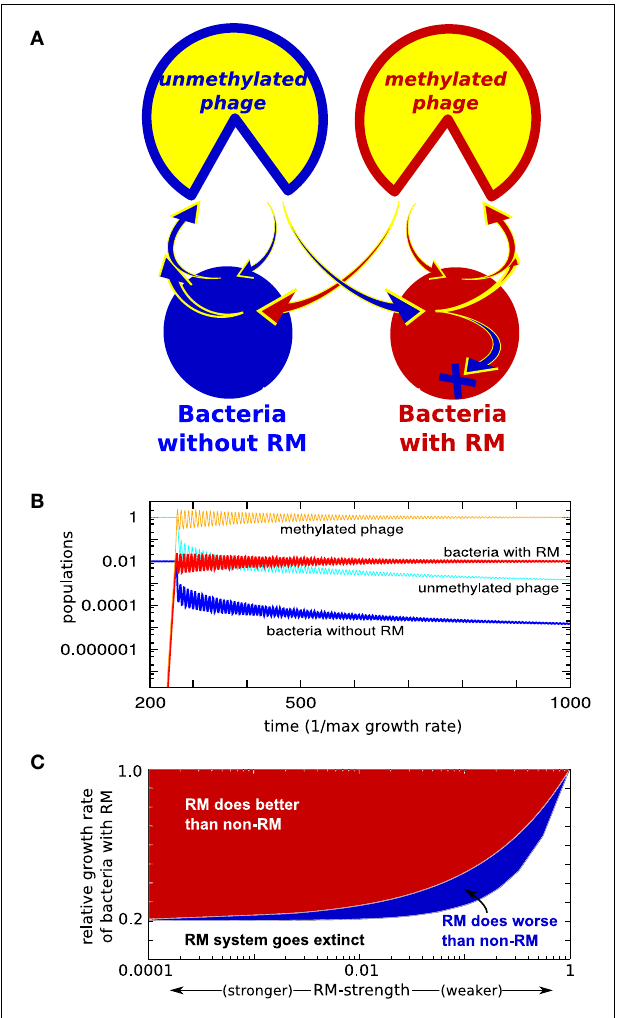
FIGURE 1 | (A) Model: Two bacterial strains exposed to one phage type. One of the strains has an RM system. (B) Simulation where the “red” strain with weak RM system with ω 1 0 . 1 is introduced to the “blue” undefended strain = ( ω 0 250 (measured in units of maximal bacterial growth rate). 1 ) at time = = (C) Coexistence of the two bacteria as function of the growth rate of the RM strain, and strength of its RM system, when dilution rate α growth rate of blue strain γ 0 1 . As long as growth rate of the RM strain = satisfies, γ 1 /γ 0 < α α ) ω 1 , the RM system will survive. And if (1 + − γ